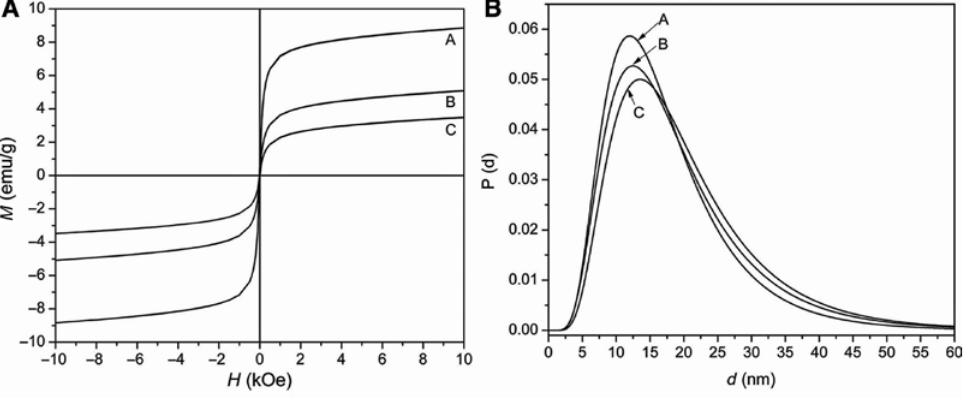
Figure 10: Magnetization properties are often related also to the grain size of respective particles. (A) Magnetization of synthesized NPs at 293 K (A: Ni Cu , B: Ni Cu , and C: Ni Cu ) versus the magnetic field and (B) corresponding grain size distribution obtained from the 67.5 32.5 62.5 37.5 60 40 magnetic measurement. Reproduced with permission from Elsevier: Journal of Alloys and Compounds [23].